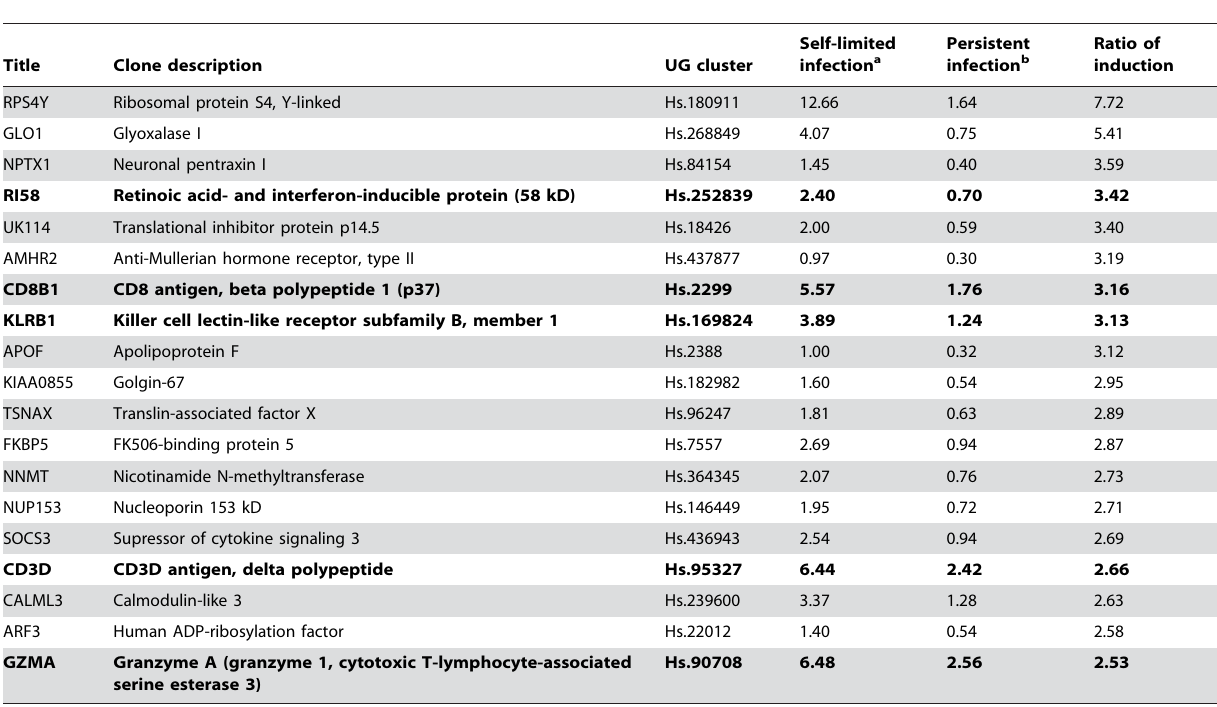
Table 4. Genes induced during the clearance phase of self-limited infection as defined by average expression